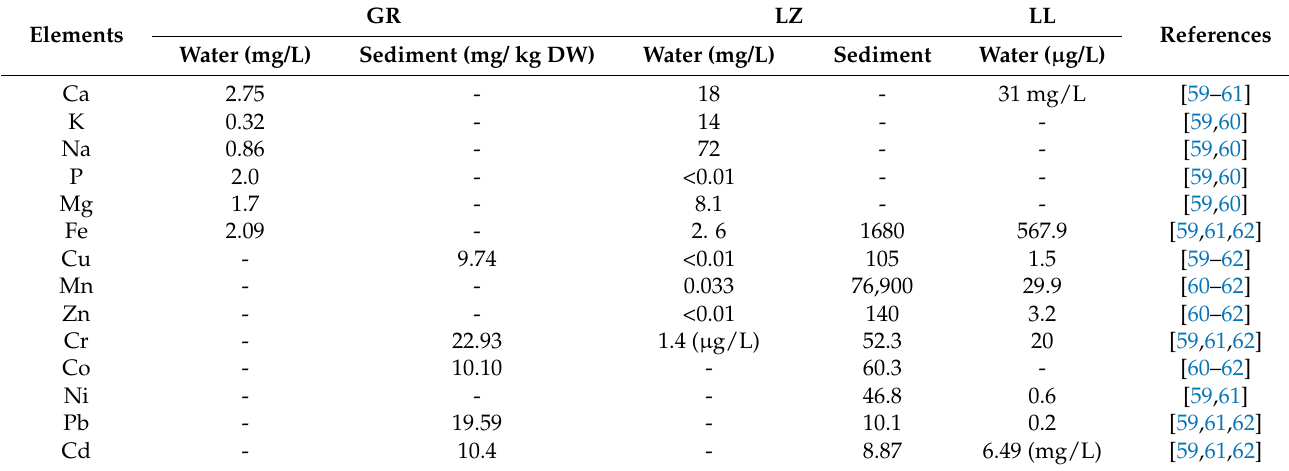
Table A3. Summary of the mean elemental concentrations in the water column and/or sediments from the three lakes, reported by different